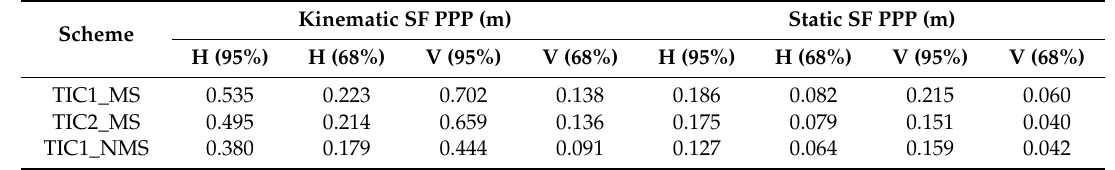
Table 9. The RMS of GPS static and kinematic SF PPP in MS and NMS of TIC1 or TIC2.